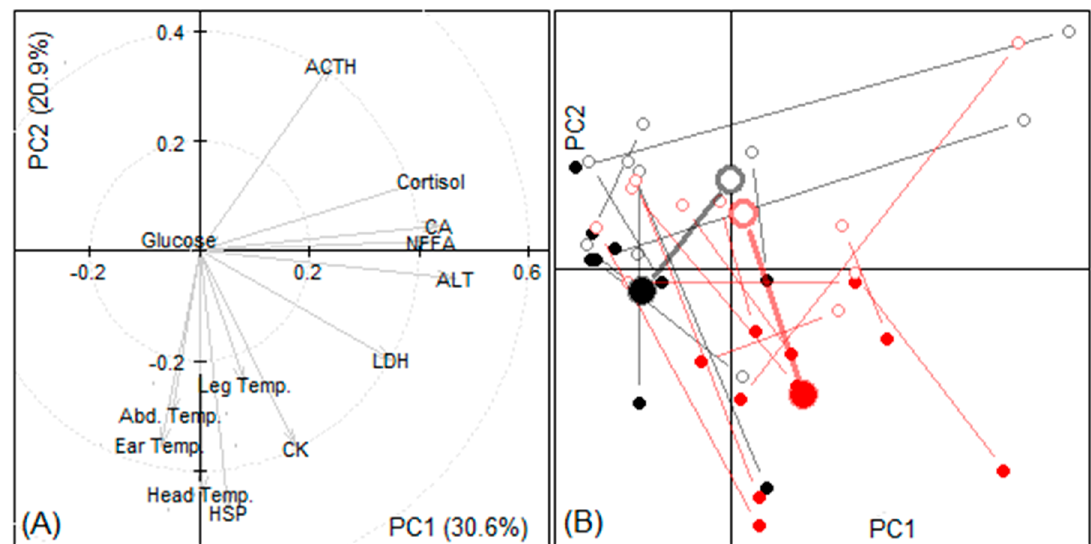
Figure 4. Results of principal component analysis of experiment 3 data. ( A ) The weights (eigenvectors) of variables in the first two principal components (PC). ( B ) Location of samples according to their first two PC scores sorted by group (red: without pre-feeding, black: with pre-feeding) and time (departure: empty circles, arrival: filled circles); samples from the same animal are joined with a line, larger circles indicate groups’ means.